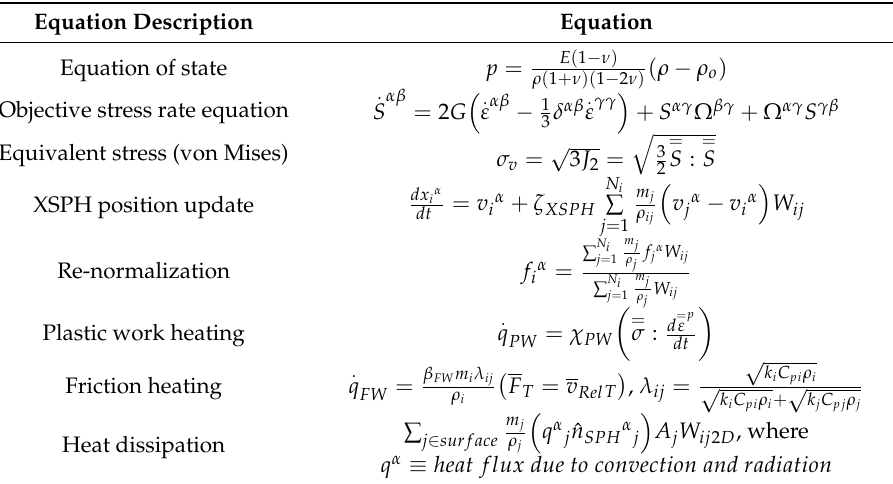
Table 2. Supporting equations.